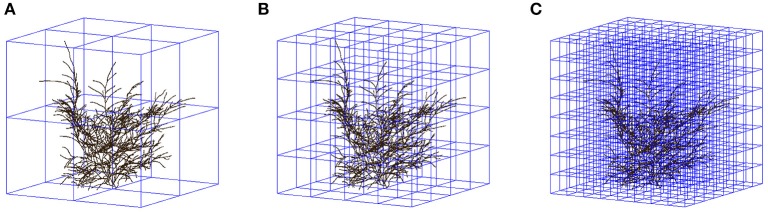
Illustration of three successive steps in the cube-counting procedure of fractal dimension estimation, i.e., the steps in which one of the smallest cubes to contain the entire skeletal branching pattern of a miniature coniferous tree (here, Microbiota decussata Gold Spot) is divided into (A) 8 = 2 × 2 × 2; (B) 64 = 4 × 4 × 4; and (C) 512 = 8 × 8 × 8 cubes which have a sidelength equal to (A) 1/2; (B) 1/4; and (C) 1/8 of the sidelength of the start cube (438). The counting of the cubes that have a non-empty intersection with at least one branch segment provides C(s) at the corresponding sidelengths and scales in Equation (1); see also the 2nd, 3rd, and 4th data points from left to right in Figure 6B, for log(1/s) = log(1/219), log(1/110), log(1/55) (after rounding of s to the nearest integer) and log(C(s)) = log(8), log(38), log(150), respectively.